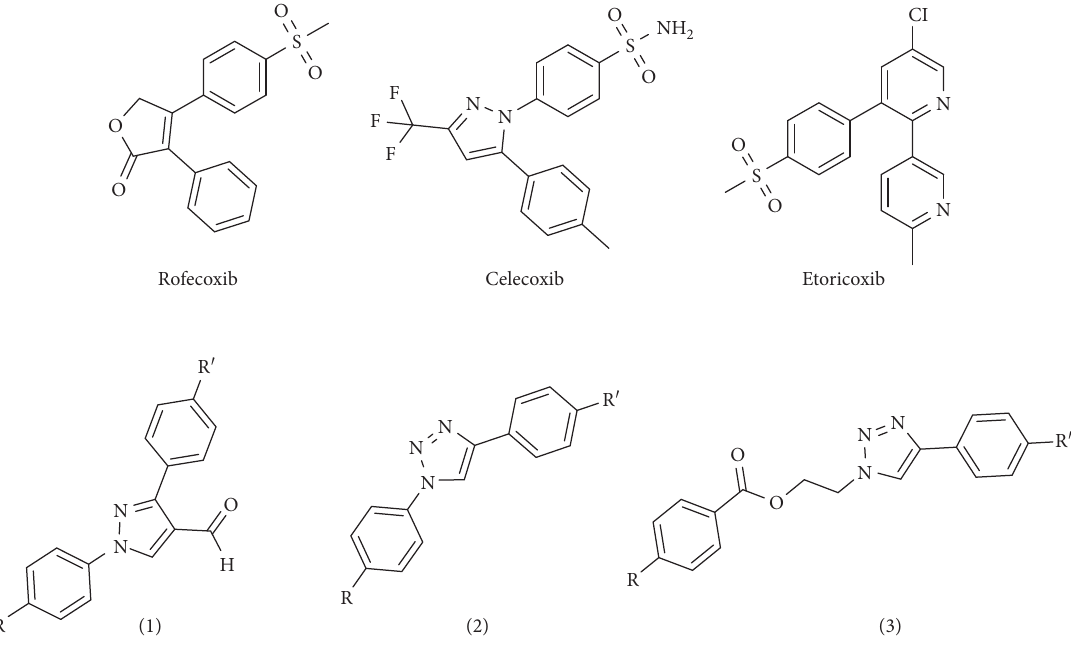
Figure 1: Structure of some selective COX-2 inhibitors and target compounds ( 1–3